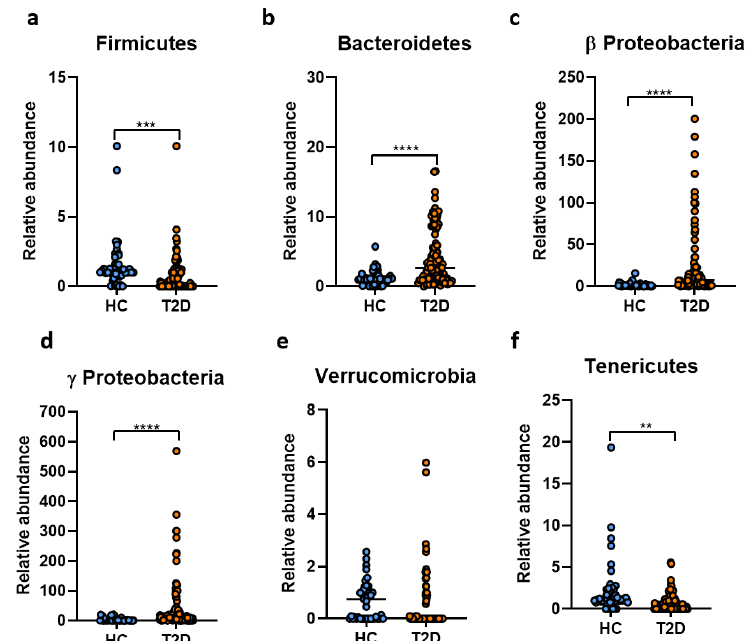
Figure 1. Microbiota analysis in T2D patients ( n = 105) versus healthy controls ( n = 45). The relative abundance of the Firmicutes ( a ), Bacteroidetes ( b ), Beta Proteobacteria ( c ), Gamma Proteobacteria ( d ), Verrucomicrobia ( e ) and Tenericutes ( f ) bacteria in fecal samples harvested from healthy individuals and T2D patients. **, p < 0.01; ***, p < 0.001, **** p < 0.0001.